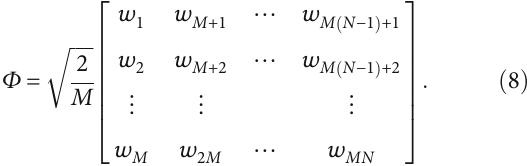
Figure 1 is the fl ow chart of the proposed algorithm.